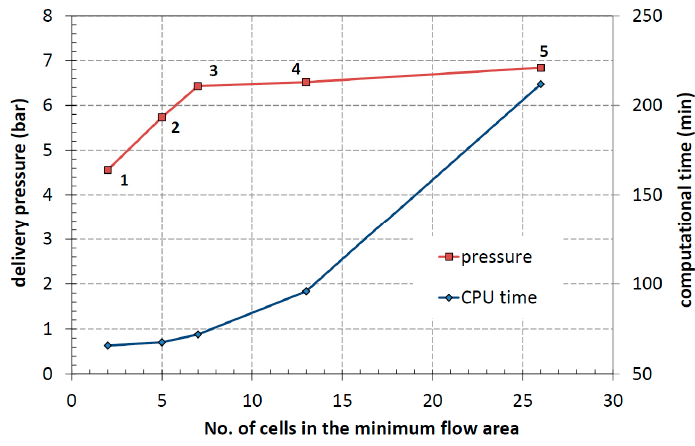
Figure 10. Regulated pressure at 2 L/min and lift 0.35 mm vs. number of cell in the minimum area.